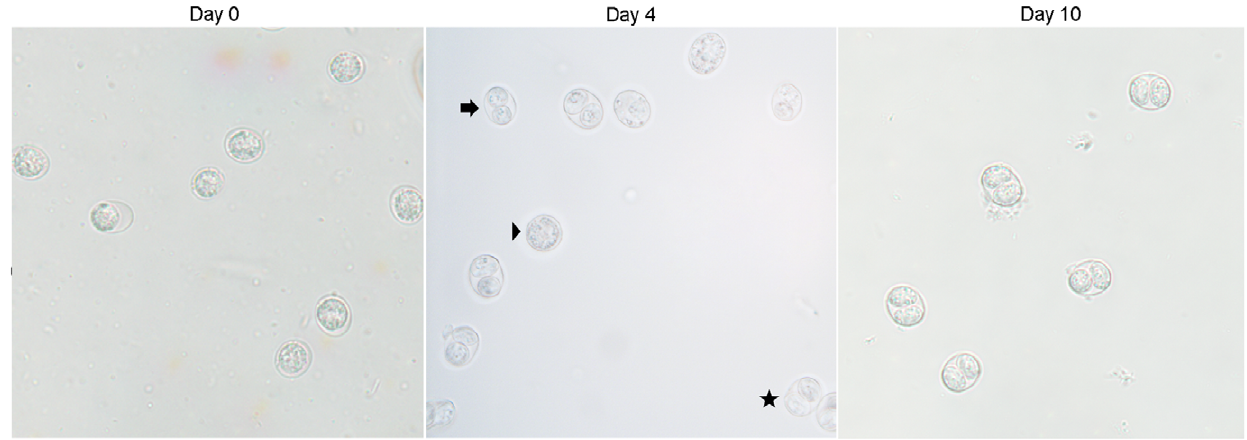
Figure 1. Toxoplasmagondii oocyst preparations used for transcriptomic analysis. Oocysts were harvested from cat feces as described in the materials and methods and isolated directly (d0; unsporulated) or after 4 (d4; mid-sporulation) or 10 (d10; sporulated) days of exposure to sporulation conditions. Day 0 oocysts are unsporulated with a primary sporoblast. Day 4 samples include unsporulated (arrowhead), partially- sporulated (star) and fully mature oocysts (arrow). Day 10 samples contain mature, sporulated oocysts.